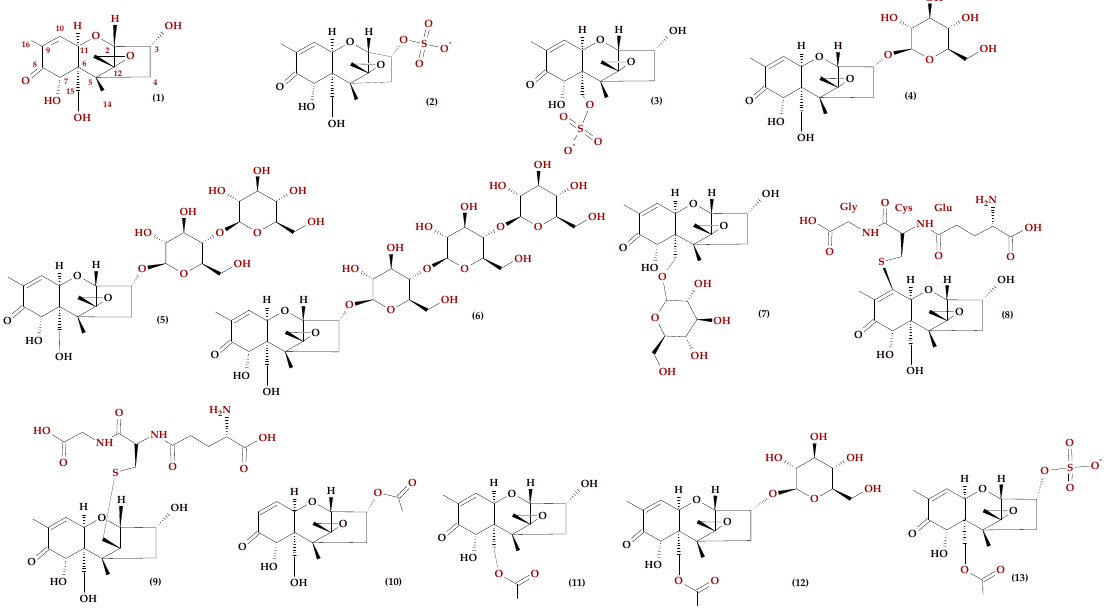
Figure 2. Chemical structure of some deoxynivalenol derivatives: ( 1 ) DON, ( 2 ) DON ‐ 3S, ( 3 ) DON ‐ 15S, ( 4 ) DON ‐ 3Glc, ( 5 ) DON ‐ diG, ( 6 ) DON ‐ triG, ( 7 ) DON ‐ 15G, ( 8 ) DON ‐ 10GSH, ( 9 ) DON ‐ 13GSH, ( 10 ) 3Ac ‐ DON, ( 11 ) 15Ac ‐ DON, ( 12 ) 15Ac ‐ DON ‐ 3Glc, ( 13 ) 15Ac ‐ DON ‐ 3S.